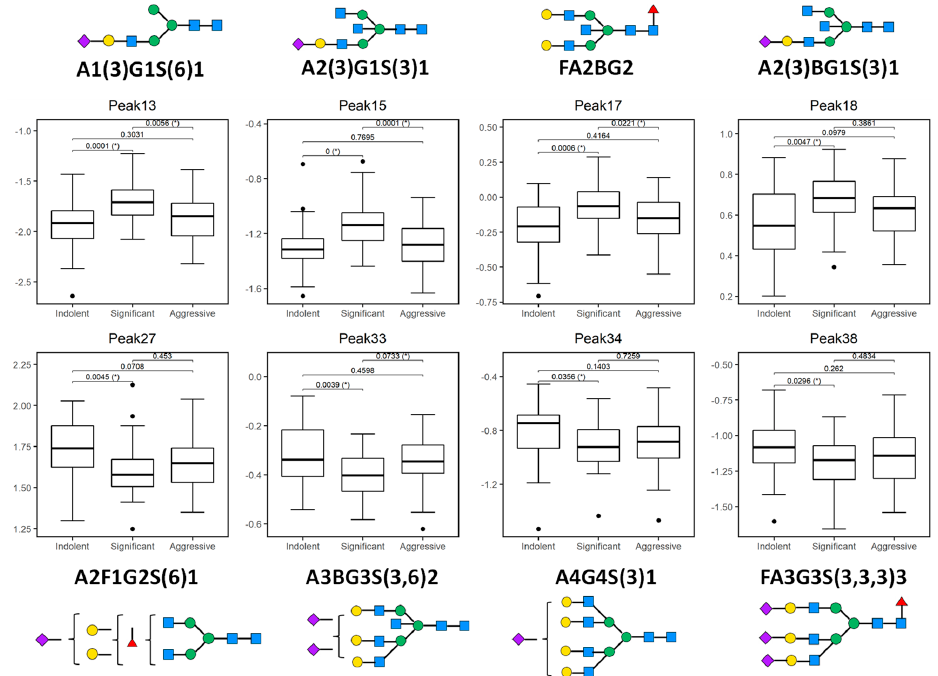
Figure 3. Plotted peaks from part of the PCa whole serum N -glycome biomarker panel—excluding those depicted in Figure 2—that show altered expression in indolent, significant, or aggressive prostate cancer (PCa) from the Irish PCRC cohort. The boxes represent the 25th and 75th percentiles with the median indicated. The lower and upper quartiles are shown as horizontal lines either side of the rectangle. From left to right, the given p -values relate to tests of di ff erences between indolent and significant, indolent and aggressive, and significant and aggressive disease types, respectively, as indicated by the brackets at the top of each plot. p -values that are significant at the 5% level are highlighted with (*). Here, all peaks show a statistically significant di ff erence between indolent and significant disease types, while peaks 13, 15, 17 and 33 additionally show a significant di ff erence between significant and aggressive